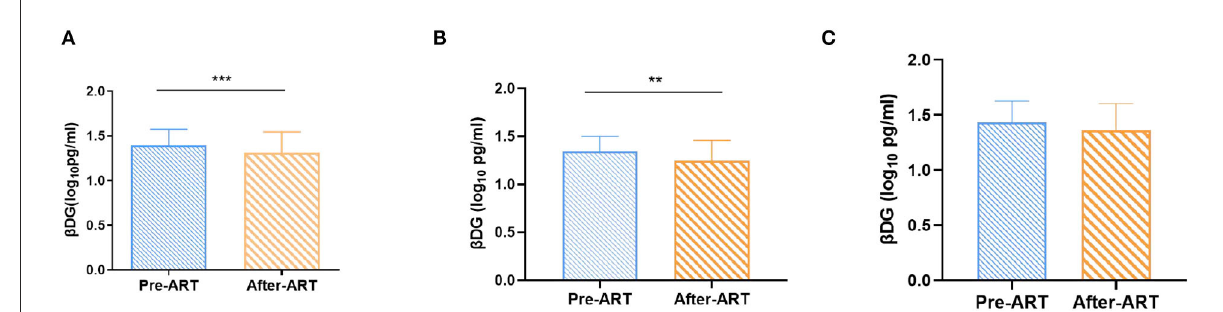
FIGURE3 Changes of β DG levels previous and after ART. (A) Total change of β DG level after ART ( n = 120). (B) Longitudinal analysis showed a decreased in β DG levels after ART in the CD4 + T cell count > 300 cells/ul group ( n = 65). (C) Longitudinal analysis showed that after ART, there was no